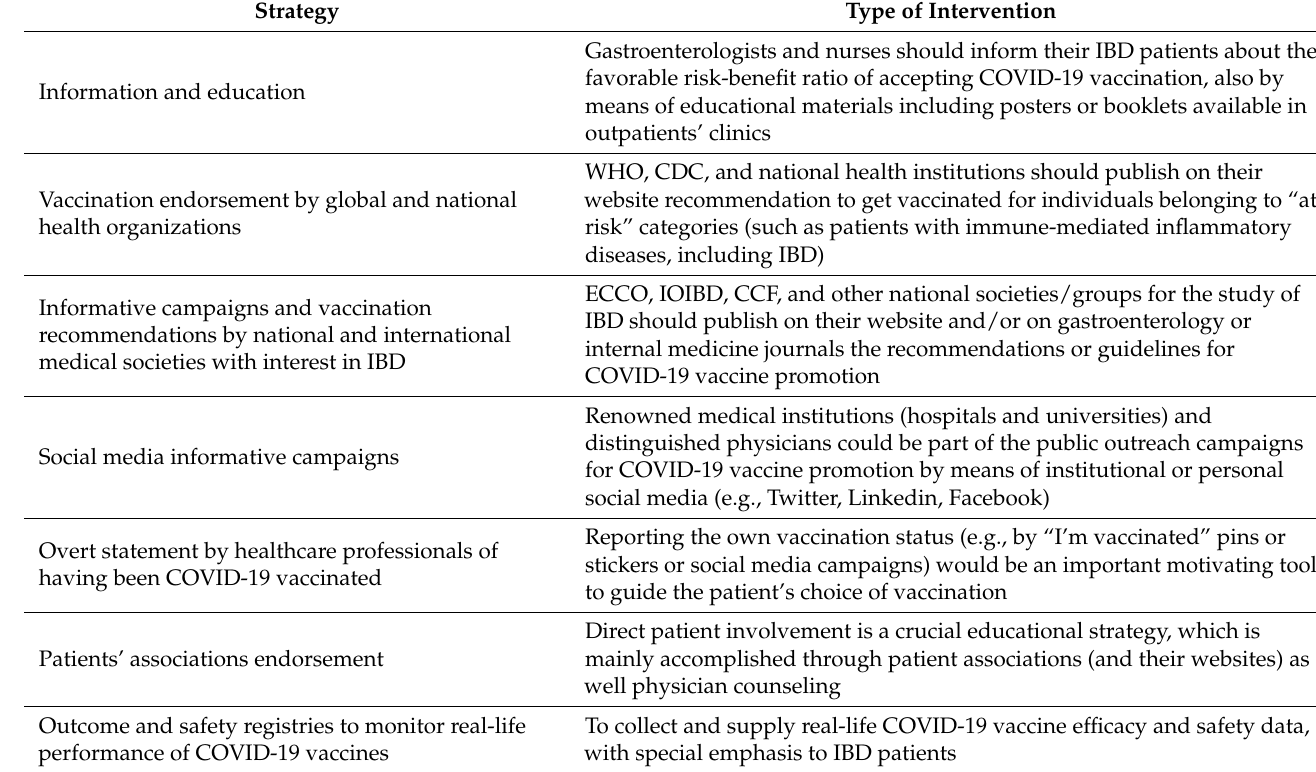
Table 2. Possible strategies for increasing adherence to SARS-CoV-2 vaccination in IBD